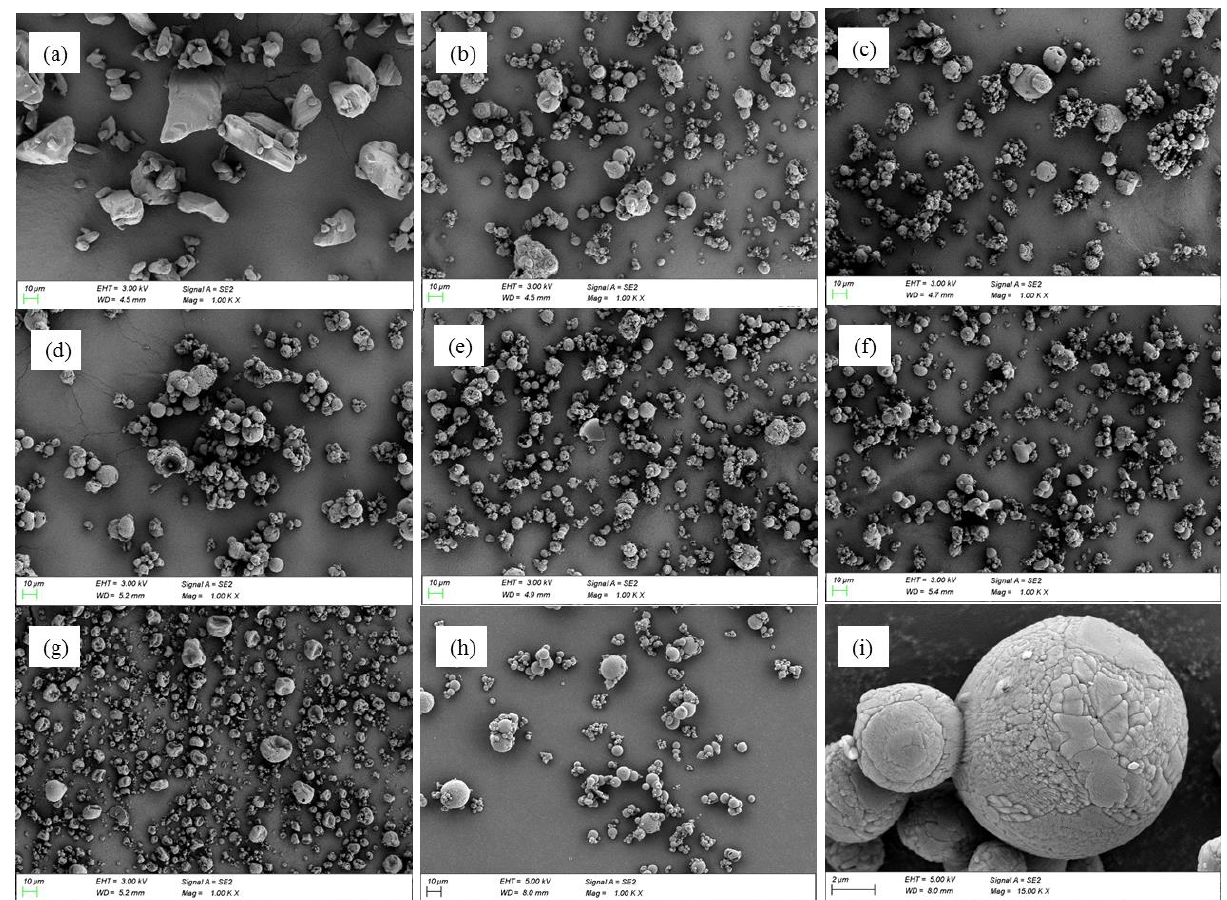
Figure 1. SEM of pure Metformin HCl and co-spray dried solid dispersion with the polymer. ( a ) Pure Met HCl, ( b ) pure Met HCl SD, ( c ) SD with sodium alginate, ( d ) SD with PVP K-30, ( e ) SD with PEG6000, ( f ) SD with polyvinyl alcohol (PVA), ( g ) SD with HPMC K15M, ( h ) SD with cetyl alcohol (×1000), ( i ) SD with cetyl alcohol (×15,000). Table 3. Results of the feasibility test for co-solid dispersion (SD) formulation.